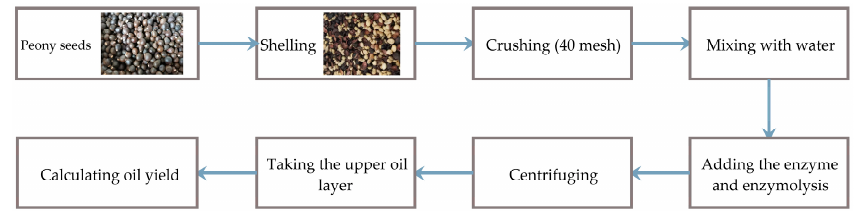
Figure 1. Workflow for aqueous enzymatic extraction of peony seed oil.